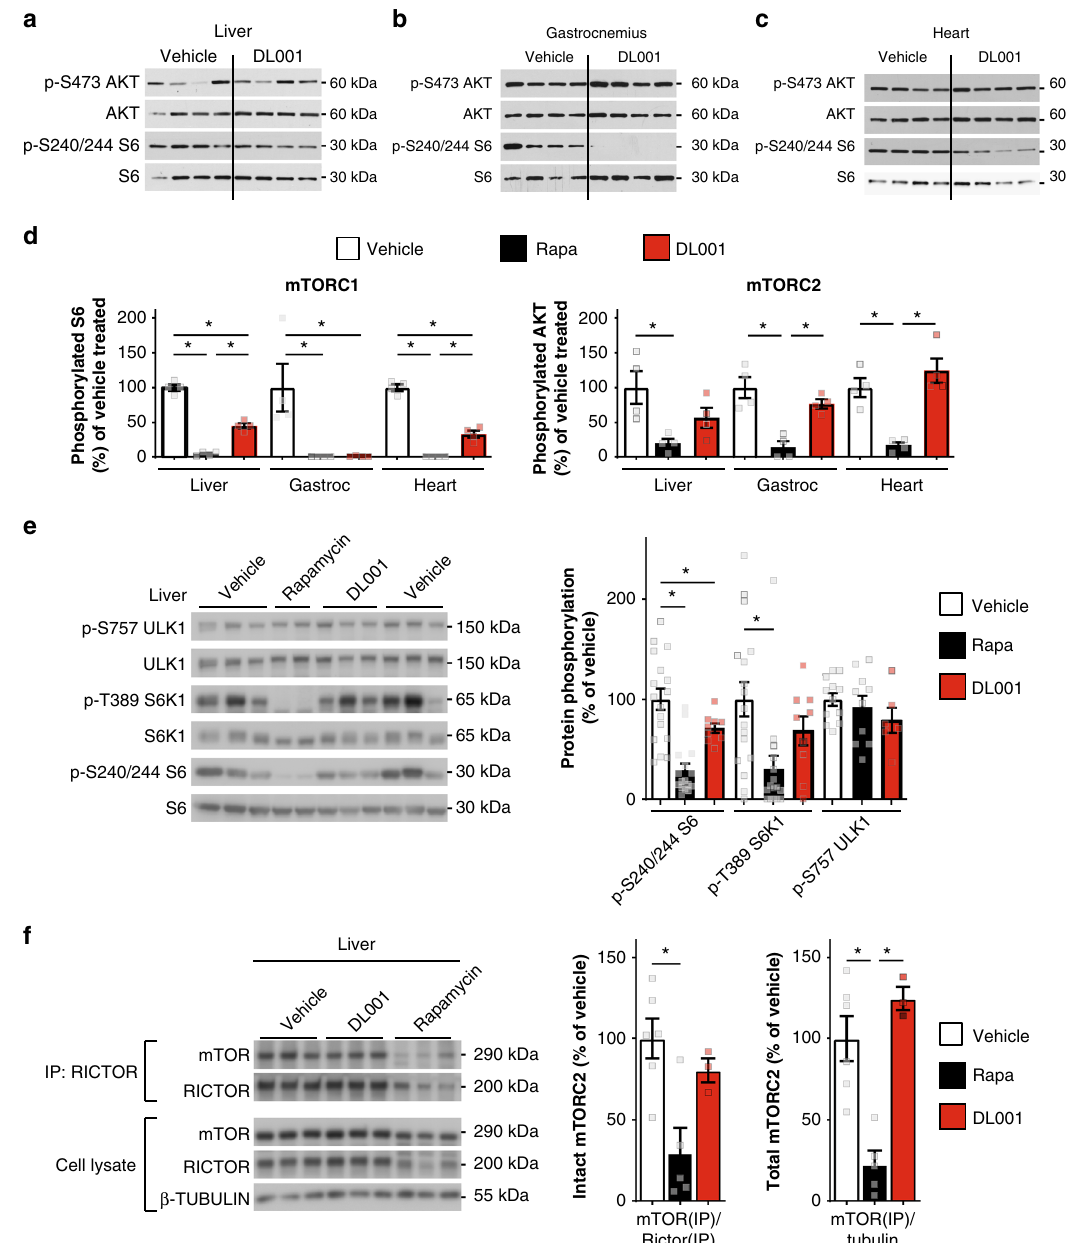
Fig. 3 DL001 selectively inhibits mTORC1 in vivo. a – d Protein lysates were prepared from the a liver, b gastrocnemius, and c heart of female C57BL/6J mice treated with vehicle or 13 mg kg − 1 DL001 every other day for 20 days, and the phosphorylation of S240/S244 S6 (a readout for mTORC1 activity) and Akt S473, an mTORC2 substrate, was determined by western blotting. d The activity of DL001 and rapamycin against mTORC1 and mTORC2 was determined by quanti fi cation of the western blots above and from mice treated in parallel with 8 mg kg − 1 rapamycin 30 using NIH ImageJ ( n = 4 biologically independent animals per group, * p < 0.05, Tukey – Kramer test following one-way ANOVA). Data from Vehicle-treated mice are plotted with white bars, rapamycin-treated mice with black bars, and DL001-treated mice with red bars. e , f C57BL/6J mice were treated with either vehicle, 8 mg kg − 1 rapamycin or 12 mg kg − 1 DL001 every other day for 5 weeks. e Quanti fi cation of phosphorylated liver proteins in vehicle, rapamycin, and DL001-treated mice ( n = 17 vehicle, 16 rapamycin, and 9 DL001-treated biologically independent animals for quanti fi cation of phosphorylated S6 and S6K1, 12 vehicle, 10 rapamycin, and 6 DL0001-treated biologically independent animals for quanti fi cation of phosphorylated ULK1; Dunnett ’ s test following one-way ANOVA, * p < 0.05). f The integrity of mTORC2 was determined by immunoprecipitation of Rictor from liver lysate; the immunoprecipitate and lysate were probed with antibodies against the indicated proteins and quanti fi ed with NIH ImageJ. mTOR(IP) and RICTOR(IP) refer to the quanti fi cation of the mTOR and RICTOR immunoblots from the RICTOR immunoprecipitate ( n = 6 vehicle, 5 rapamycin, and 3 DL001-treated biologically independent animals, * p < 0.05, Tukey – Kramer test following one-way ANOVA). e , f Data from Vehicle-treated mice are plotted with white bars, rapamycin-treated mice with black bars, and DL001-treated mice with red bars. Error bars represent standard error. Source data are provided as a Source Data fi